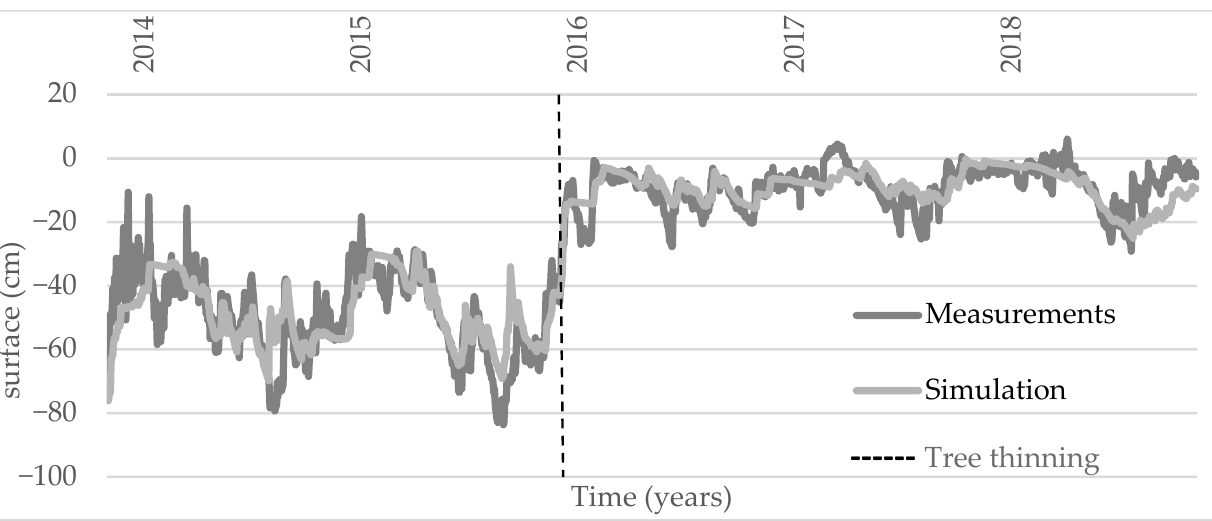
Figure 7. Measured vs. simulated groundwater level in plot 4.